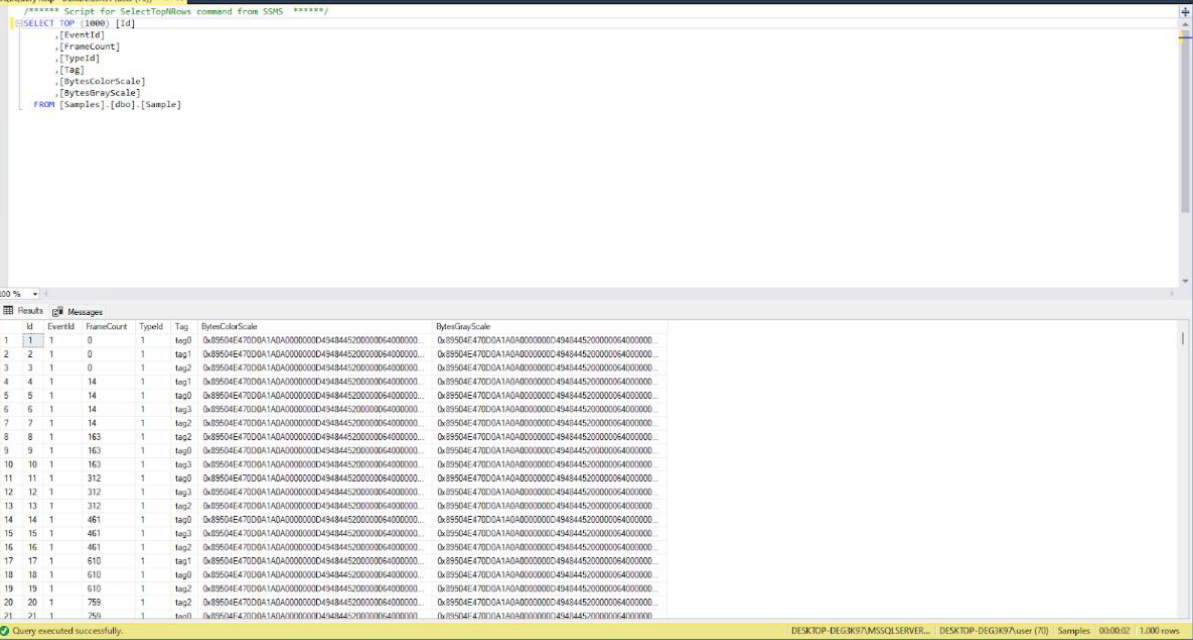
Figure 6. SQL Query for 1000 records – samples into SQL Server.